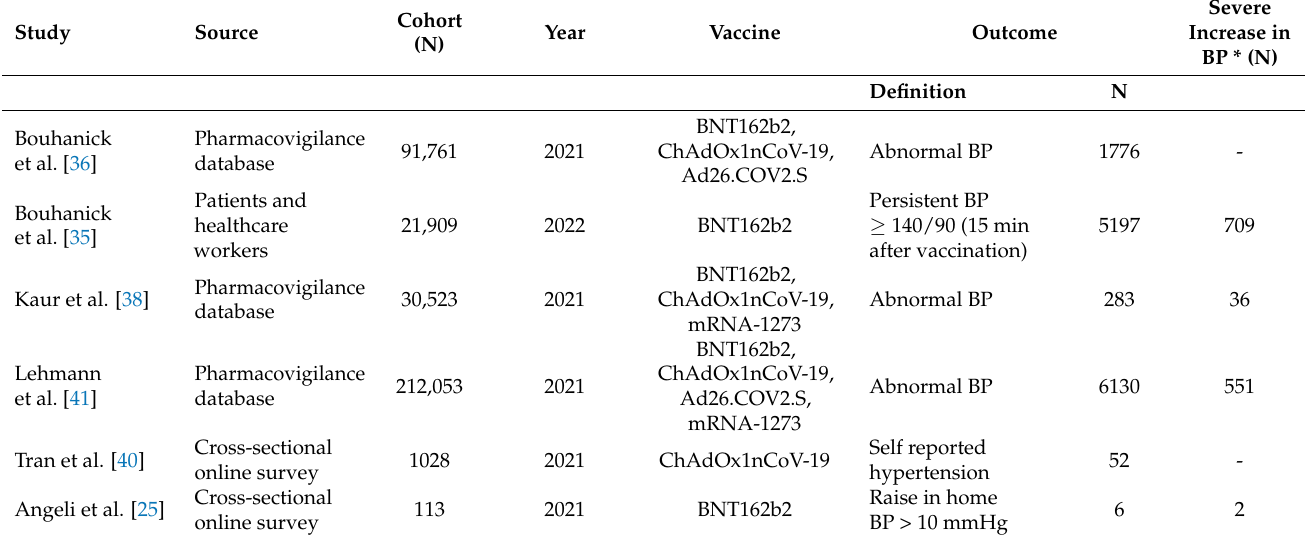
Table 2. Main features of studies included in the